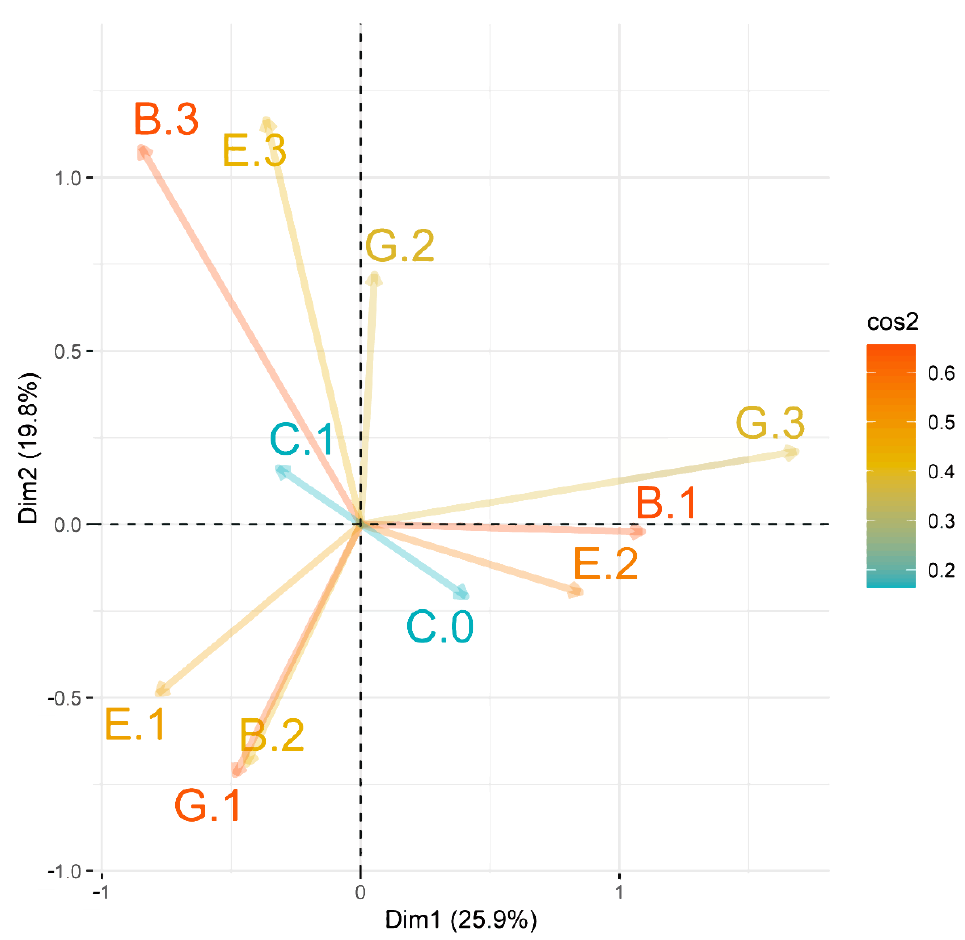
Figure 6. Graphic representation of the variables of the MCA colored according to their quality of representation (B = number of samples collected per year and per individual; C = number of sex markers used; E = number of STRs used; G = number of sample type). Figures refer to the classes from Table 1 (see 2.5).